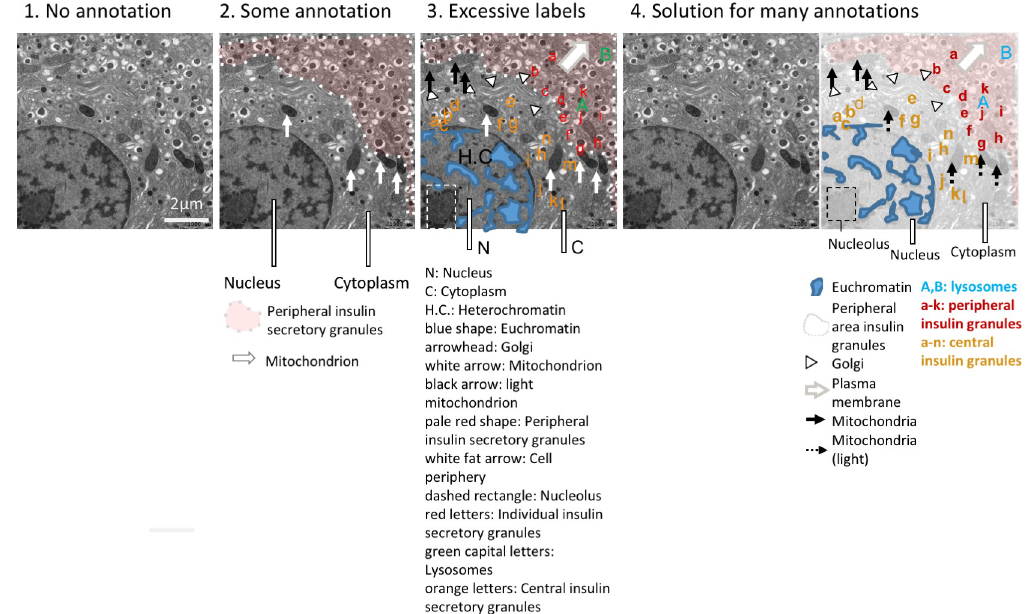
Fig 11. Different levels of detail for image annotations. Annotations help to orient the audience but may also obstruct parts of the image. Authors must find the right balance between too few and too many annotations. (1) Example with no annotations. Readers cannot determine what is shown. (2) Example with a few annotations to orient readers to key structures. (3) Example with many annotations, which obstruct parts of the image. The long legend below the figure is confusing. (4) Example shows a solution for situations where many annotations are needed to explain the image. An annotated version is placed next to an unannotated version of the image for comparison. The legend below the image helps readers to interpret the image, without having to refer to the figure legend. Note the different requirements for space. Electron microscope images show mouse pancreatic beta-islet